Question: In one sentence, what is this figure communicating?
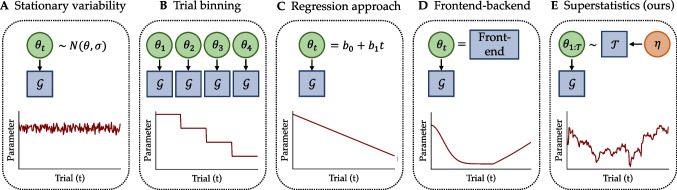
Answer: A conceptual illustration of the five main approaches to model temporal variation in the parameters \documentclass[12pt]{minimal} \usepackage{amsmath} \usepackage{wasysym} \usepackage{amsfonts} \usepackage{amssymb} \usepackage{amsbsy} \usepackage{mathrsfs} \usepackage{upgreek} \setlength{\oddsidemargin}{-69pt} \begin{document}$$\theta $$\end{document} θ of a cognitive model \documentclass[12pt]{minimal} \usepackage{amsmath} \usepackage{wasysym} \usepackage{amsfonts} \usepackage{amssymb} \usepackage{amsbsy} \usepackage{mathrsfs} \usepackage{upgreek} \setlength{\oddsidemargin}{-69pt} \begin{document}$$\mathcal {G}$$\end{document} G . A Stationary variability , also known as inter-trial variability, assumes that parameter values fluctuate around a stable mean. B Trial binning involves organizing the data into distinct bins and fitting a cognitive model \documentclass[12pt]{minimal} \usepackage{amsmath} \usepackage{wasysym} \usepackage{amsfonts} \usepackage{amssymb} \usepackage{amsbsy} \usepackage{mathrsfs} \usepackage{upgreek} \setlength{\oddsidemargin}{-69pt} \begin{document}$$\mathcal {G}$$\end{document} G to each bin individually. C Regression approach employs time (and sometimes additional contextual variables) as predictors for the parameters \documentclass[12pt]{minimal} \usepackage{amsmath} \usepackage{wasysym} \usepackage{amsfonts} \usepackage{amssymb} \usepackage{amsbsy} \usepackage{mathrsfs} \usepackage{upgreek} \setlength{\oddsidemargin}{-69pt} \begin{document}$$\theta $$\end{document} θ . D Frontend-backend models employ a mechanistic model, referred to as the frontend, to elucidate the dynamics of the parameter of the cognitive model (i.e., the backend). E Superstatistics involve a superposition of multiple stochastic processes operating on different temporal scales. They comprise a low-level observation model \documentclass[12pt]{minimal} \usepackage{amsmath} \usepackage{wasysym} \usepackage{amsfonts} \usepackage{amssymb} \usepackage{amsbsy} \usepackage{m